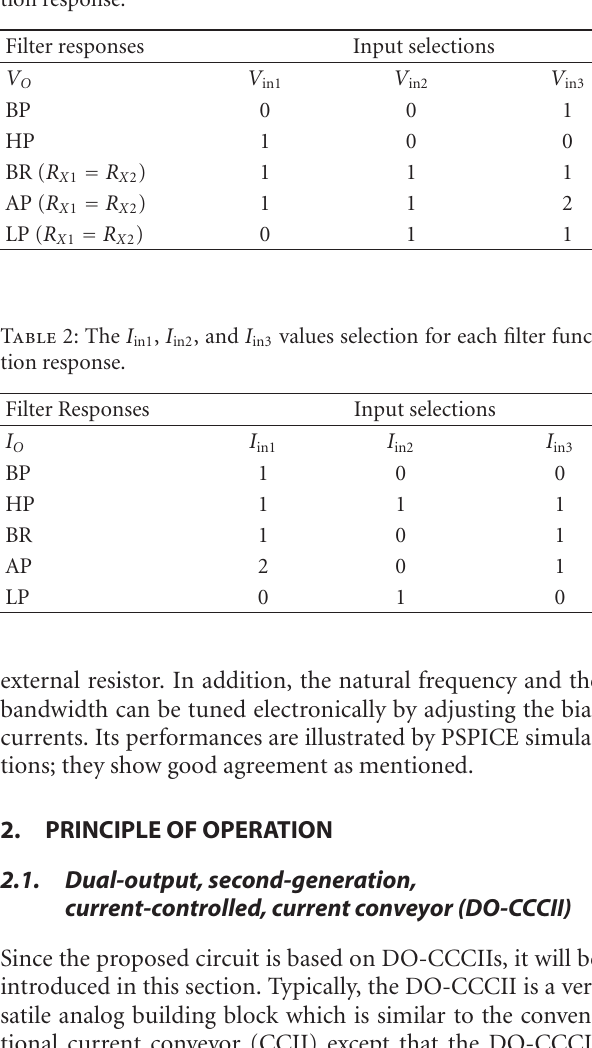
Table 1: The V in1 , V in2 , and V in3 values selection for each filter func- tion response.